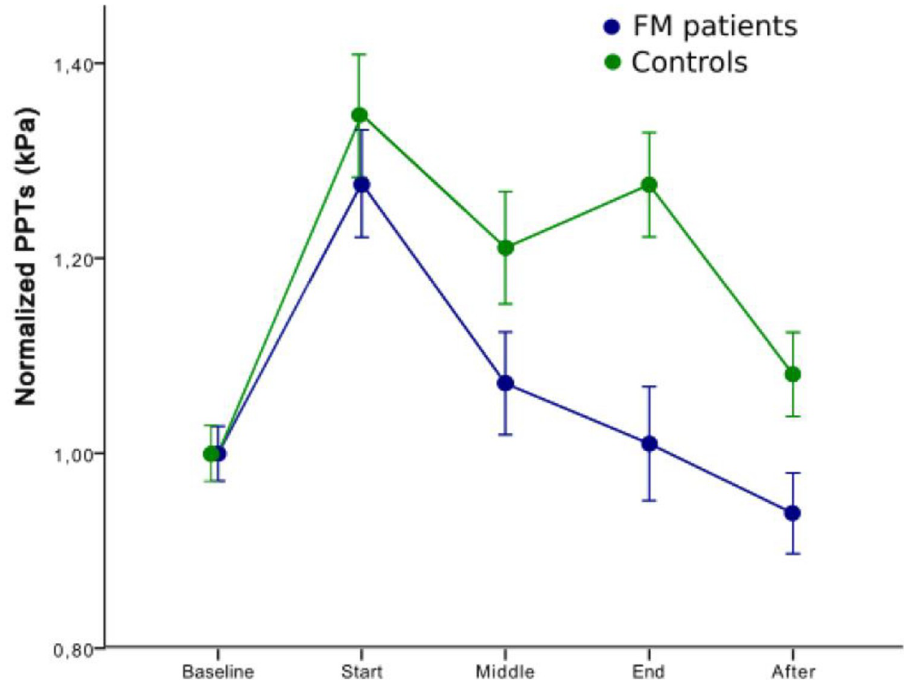
Fig 5. Normalized pressure pain thresholds (PPTs) (mean ± SEM) at start, middle, end and 5 minutes after a standardized tourniquet test. The conditioning pain was applied in the upper left arm and PPTs were assessed at the contralateral m . quadriceps in FM patients and healthy controls. There was a statistically significant difference between the groups at end (p < 0.001) and after (p = 0.041) the